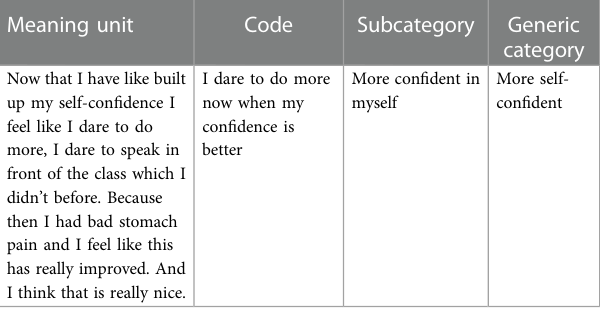
TABLE 3 Example of the analysis process. Meaning unit